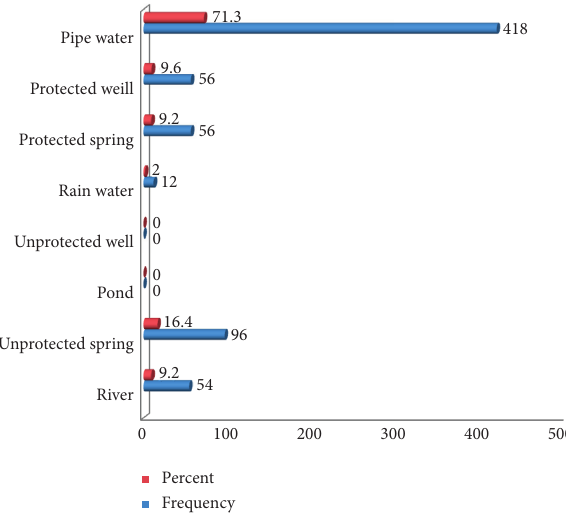
Figure 2: Source of water for domestic use in Areka Town in Southern Ethiopia,